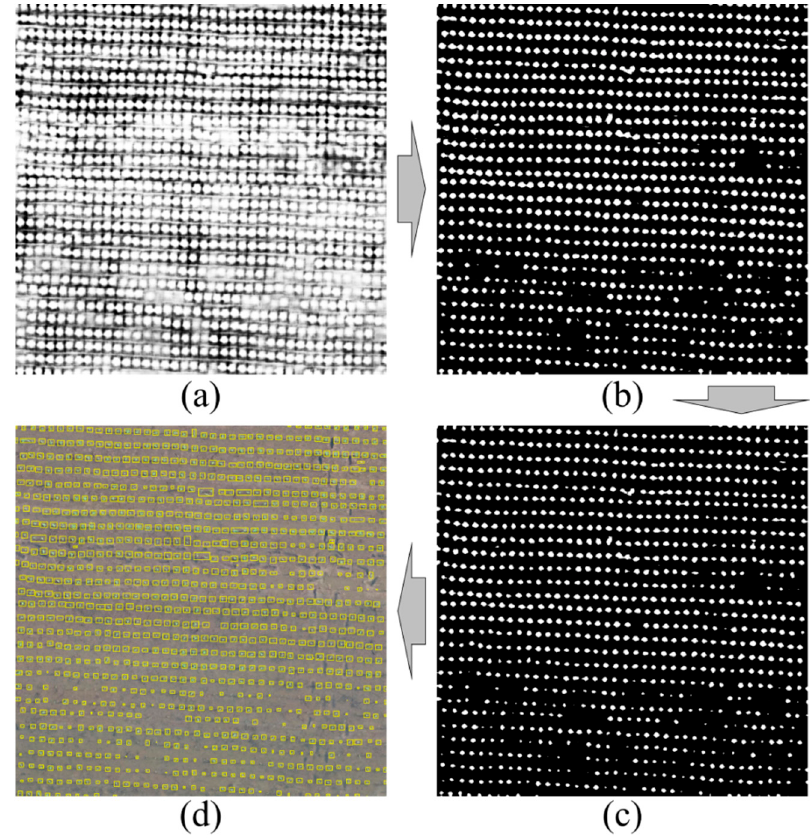
Figure 10. The post-process of patch-based rice seedling detection in Subset 7. ( a ) heatmap of classification results; ( b ) result image obtained from a binarization process with a 0.99 threshold; ( c ) result image obtained from a diamond-shaped erosion process; ( d ) RGB image with drawn bounding boxes of detected objects for